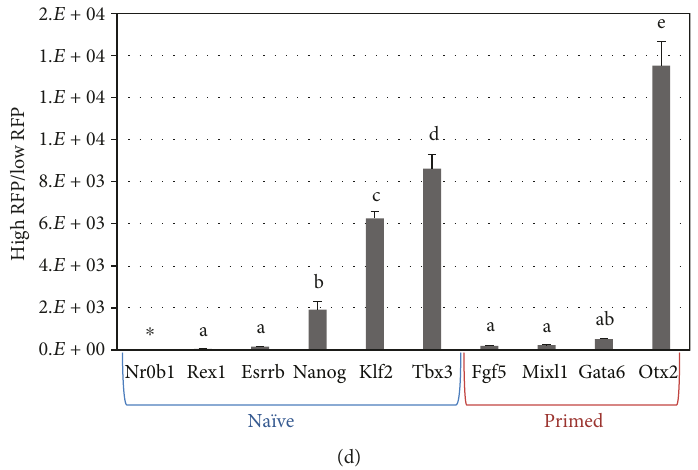
Figure 6: Comparison of naïve- or primed-state-related gene expression between low- and high- fl uorescent cells sorted by fl uorescence-activated cell sorting. Comparison of marker gene expression from naïve ( Tbx3 , Nr0b1 , Rex1 , Esrrb , Nanog , and Klf2 ) and primed ( Gata6 , Mixl1 , Fgf5 , and Otx2 ) cells using a dual-reporter assay consisting of DE-GFP (p OCT4 - Δ PE-eGFP) and PE-RFP (p OCT4 - Δ DE-DsRed2). (a) Embryonic stem cells sorted by the DE-GFP signal. Low GFP/high GFP means that the expression level of genes in GFP-low-expressing cells is divided by that in GFP-high-expressing cells. (b) Embryonic stem cells sorted by the PE-RFP signal. Low RFP/high RFP means that the expression level of genes in RFP-low-expressing cells is divided by that in RFP-high-expressing cells. (c) Embryonic carcinoma cells sorted by the DE-GFP signal. High GFP/low GFP means that the expression level of genes in GFP-high-expressing cells is divided by that in GFP-low-expressing cells. (d) Embryonic carcinoma cells sorted by the PE-RFP signal. High RFP/low RFP means that the expression level of genes in RFP-high-expressing cells is divided by that in RFP-low-expressing cells. The asterisk indicates that no values were